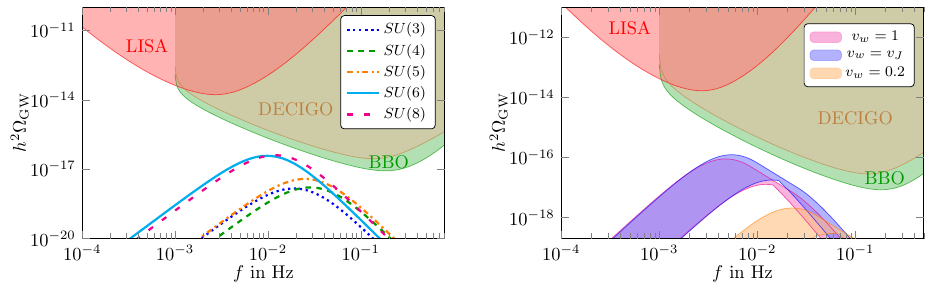
Figure 1. GW spectra from the SU( N c ) confinement phase transition without quarks for di ff erent values of N c and v w = v J (left) as well as for N c = 6 and di ff erent wall velocities (right). Figures taken from